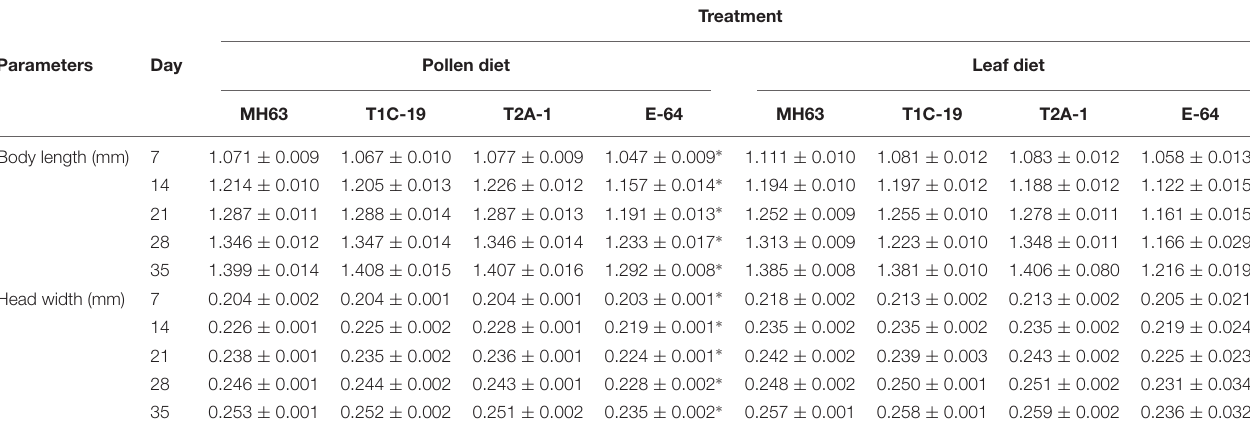
TABLE 1 | Body length and head width of Folsomia candida that fed on a diet consisting of non- Bt pollen/leaf (MH63, negative control), Bt pollen/leaf (T1C-19: Cry1C, and T2A-1: Cry2A), or non- Bt pollen/leaf plus E-64 protein (E-64, positive control) for 35 days.